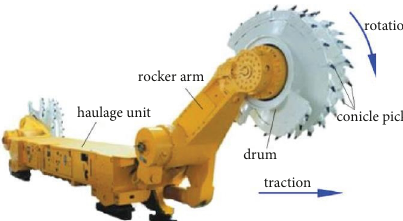
Figure 2: The structural and working principle of